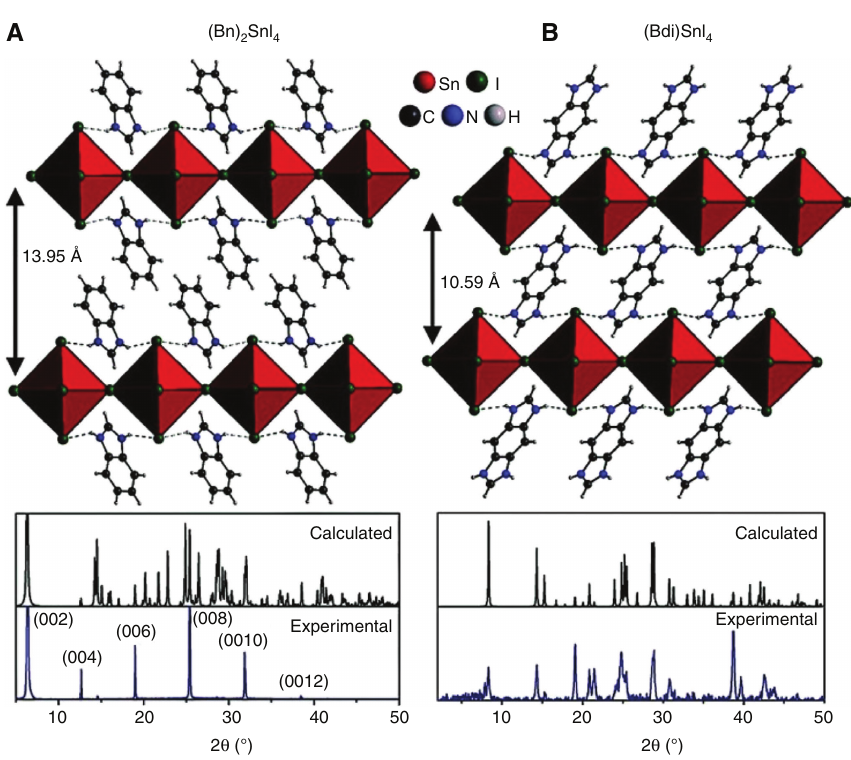
Figure 4: Effect of interlayer spacing on perovskites. Structural drawings of the 2D perovskites [benzimidazolium] direction. The d -spacing between the single perovskite sheets indicated. The corresponding diffraction patterns of the 2D perovskites spin-coated on glass substrates are shown underneath. Reprinted from Ref. [90] with permission from the Wiley-VCH.